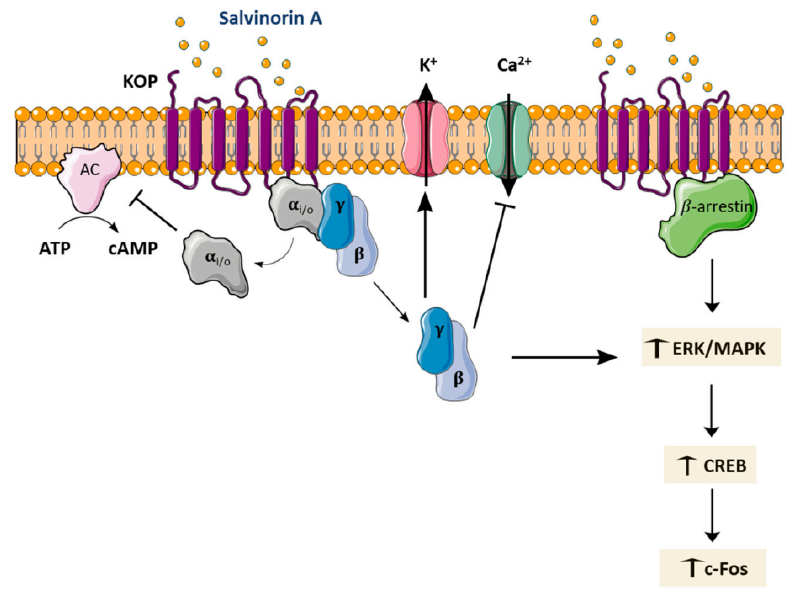
Figure 4. Schematic representation of the downstream pathways triggered by κ -opioid receptor (KOP) activation by salvinorin A. Following KOP activation, the G α subunit of Gi/o proteins dissociates from the G βγ subunit, with these consequently interacting with intracellular effectors [114]. The production of cyclic adenosine monophosphate (cAMP) by adenylyl cyclase (AC) is inhibited and causes the activation of inward-rectifying K + channels, and inhibition of N-type, P-type, Q-type, and R-type voltage-activated Ca 2+ channels, leading to an inhibitory effect on neurotransmitter release [115,116]. Additional downstream signalling pathways involve the activation of β -arrestin and phosphorylation of extracellular signal-regulated kinases (ERKs)/mitogen-activated protein kinases (MAPKs) by G βγ subunits. This leads to activation of cAMP response element-binding protein (CREB), and a consequent increase in c-Fos expression. ATP: Adenosine